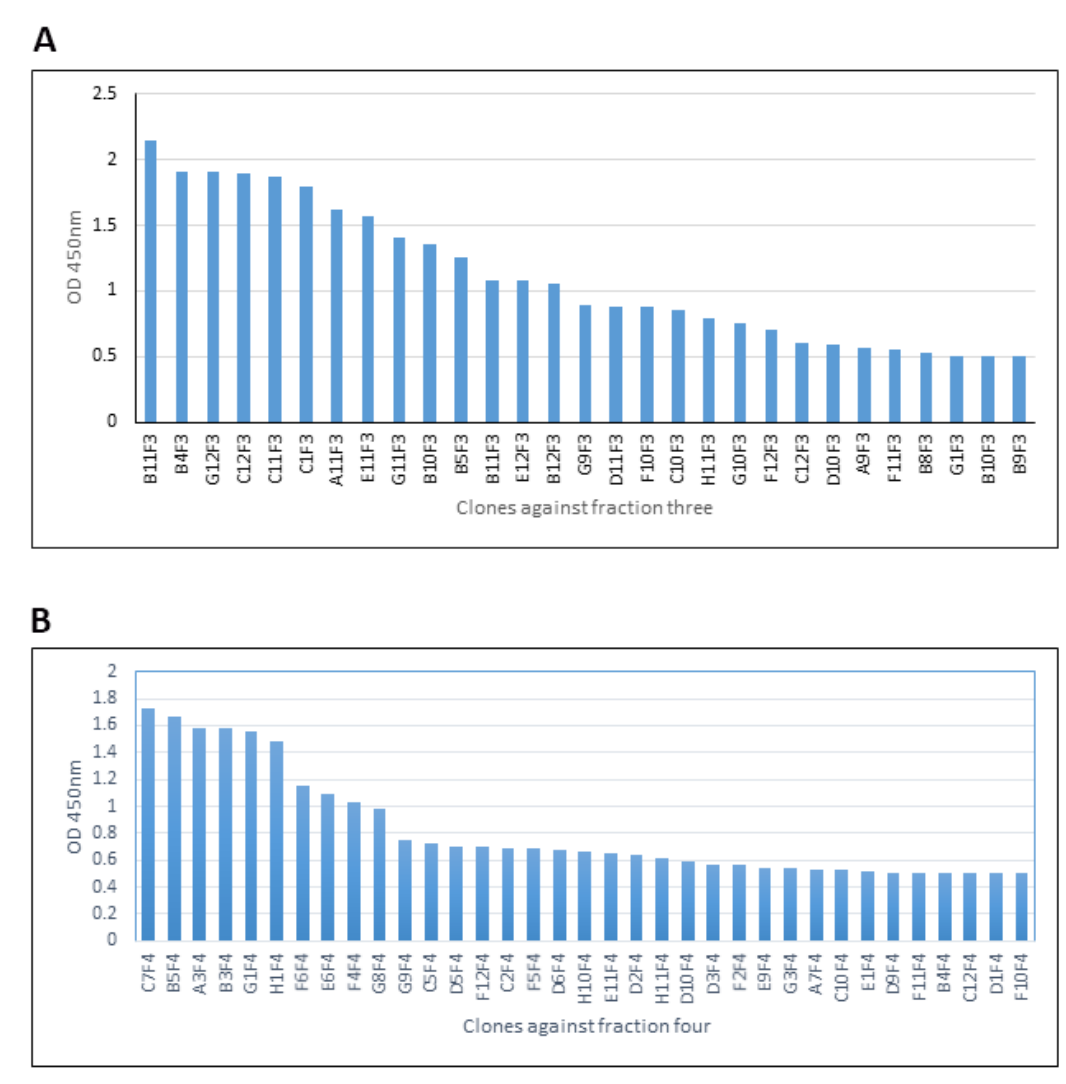
Figure 4. Monoclonal phage ELISA of phage isolated from antibody library I against (A) fraction F3 and (B) fraction